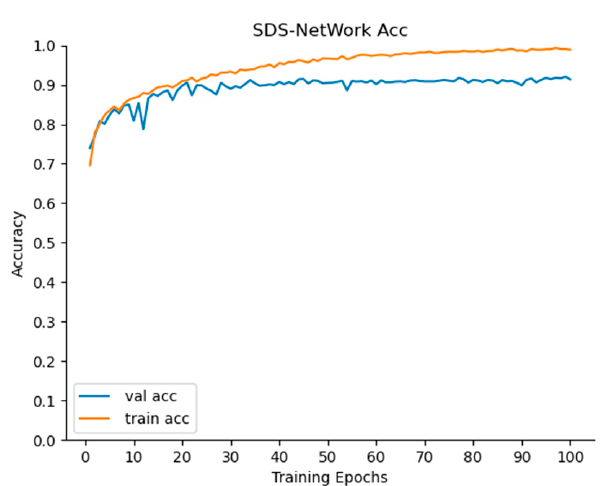
Figure 5. Acc curve of accuracy rate of SDS-Network